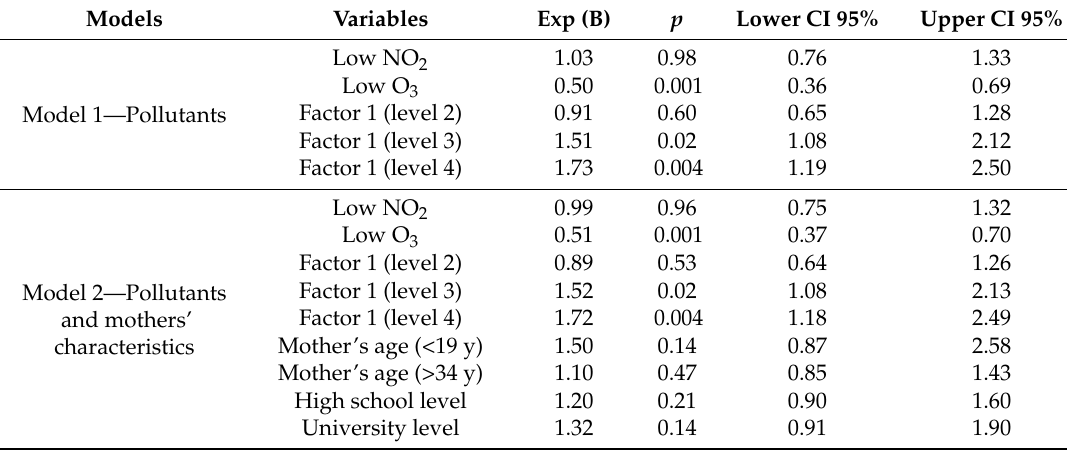
Table 5. Multivariate logistic model with preterm and variables related to air pollution, the characteristics of mothers, and the onset of prenatal